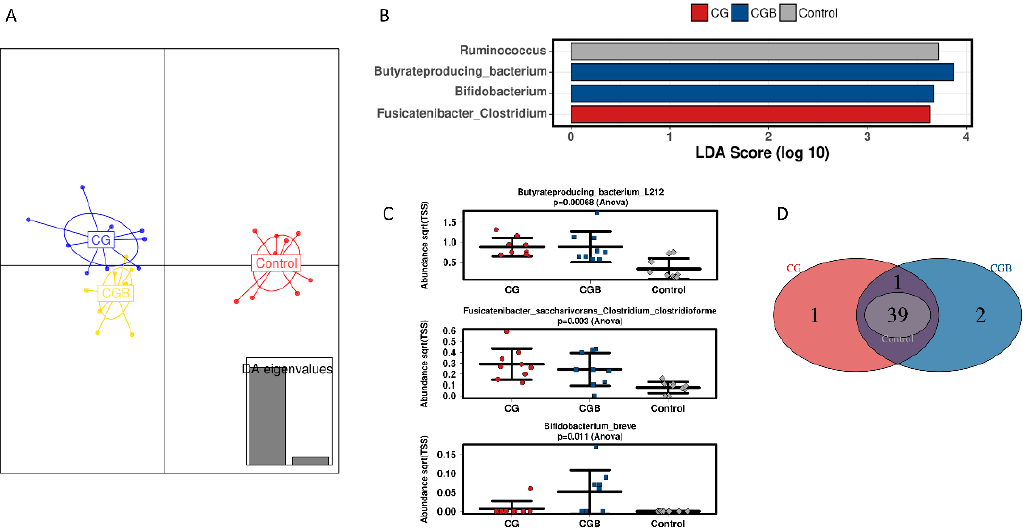
Figure 3. Effect of GC and GCB treatments on mucosal microbial composition. ( A ) Discriminant analysis of principal components (DAPC) plot of the mucosal compartment at family level; ( B ) core microbiota at OTU level; ( C ) linear discriminant analysis effect size (LEfSe) at family level; ( D ) selected significant different features at OTU level between control and treatments. Graphs represent 16S rRNA sequencing data from three healthy individuals (n = 3) in technical triplicates (n =